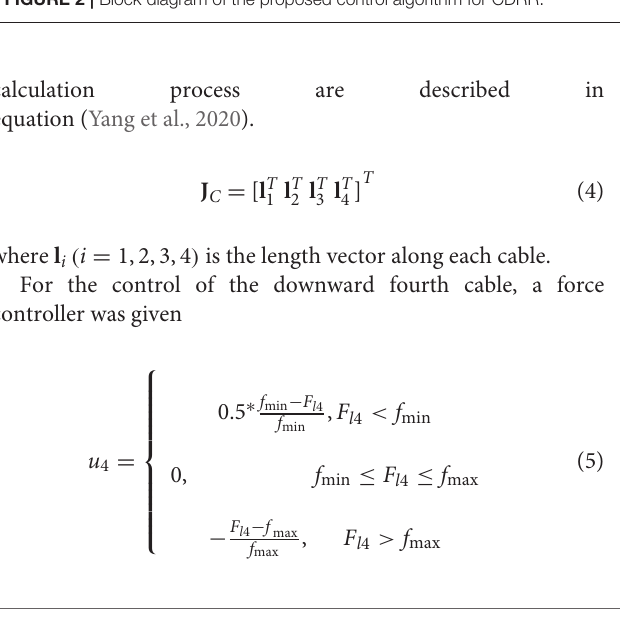
FIGURE 2 | Block diagram of the proposed control algorithm for